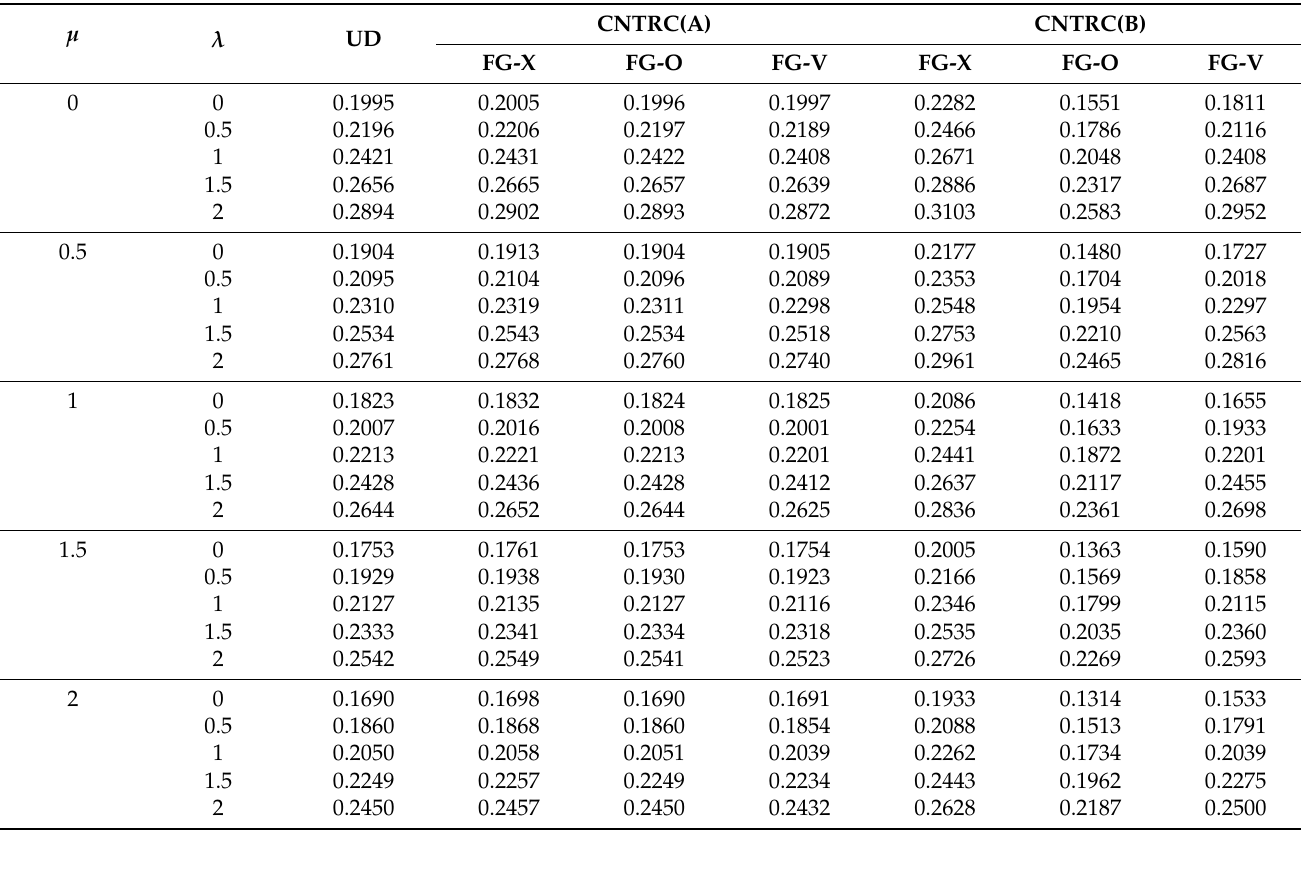
Table 7. Effect of nonlocal and length scale parameters on the dimensionless frequency of spherical